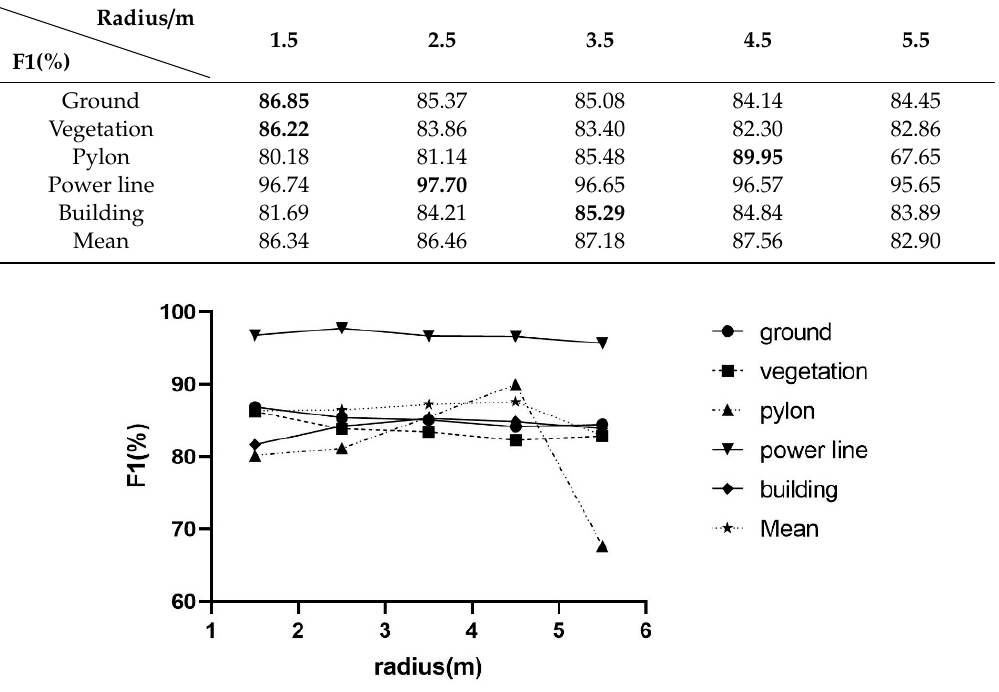
Figure 13. The sensitivity analysis of neighborhood radius for different classes based on the RF classifier.